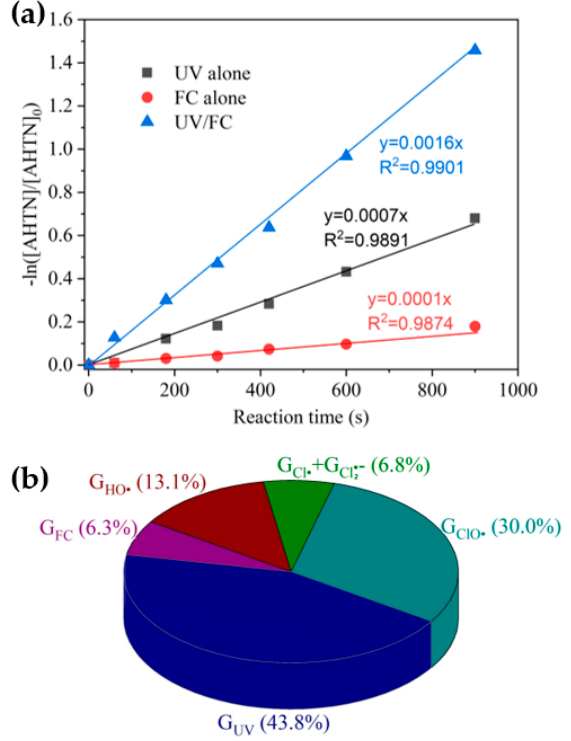
Figure 2. Degradation of AHTN by UV/FC—( a ) first-order kinetic fitting and ( b ) contribution analysis of relevant contributors ([AHTN] 0 = 1.0 mg · L − 1 ; pH = 7.0; 25 ± 1 ◦ C; [FC] 0 = 3.28 mg · L − 1 ; [Cl − ] 0 = 0.02 mM; and UV fluence rate 0.067 mW · cm − 2 [